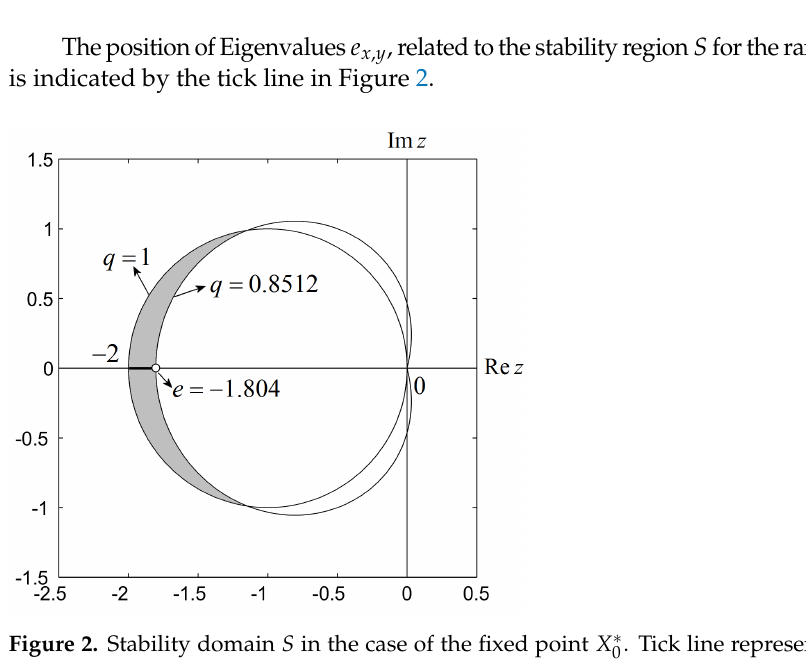
. Tick line represents the asymptotic 0